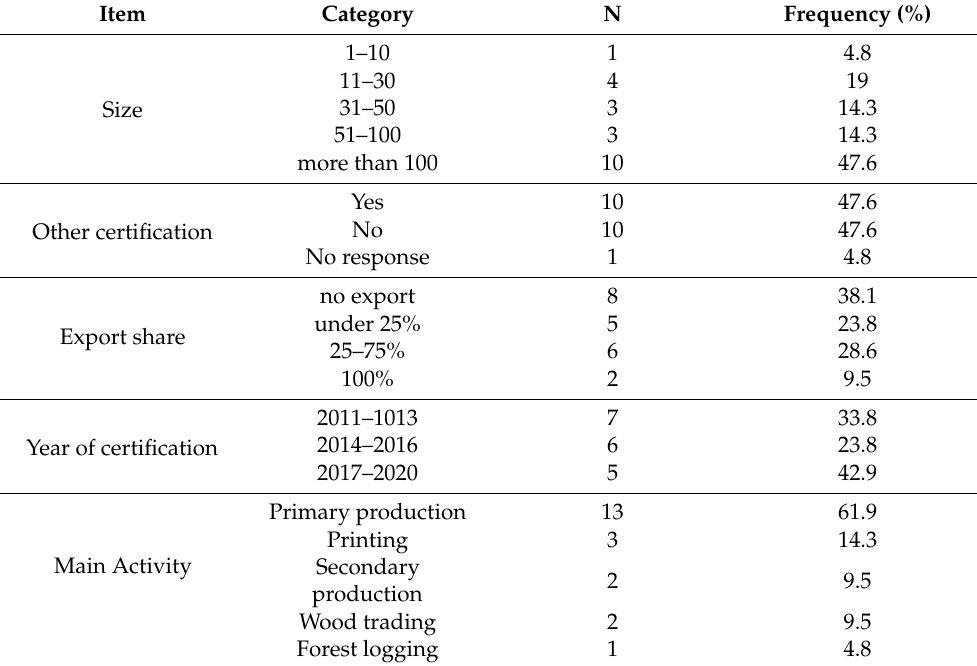
Table 1. Descriptive statistics of the general information about the